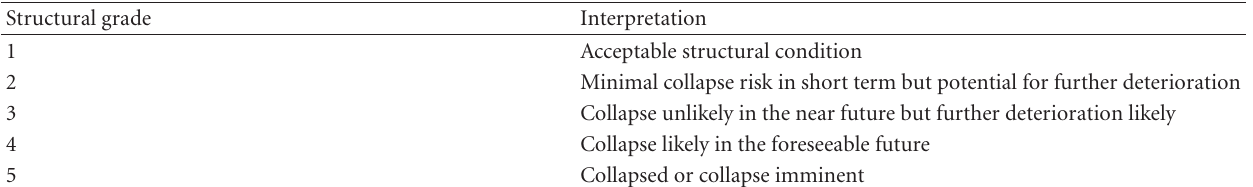
Table 1: Example sewer grading scheme.